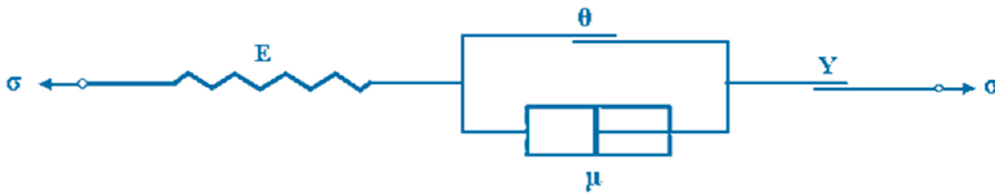
Figure 13. Representation of modified Bingham model with spring, dashpot and slider elements.